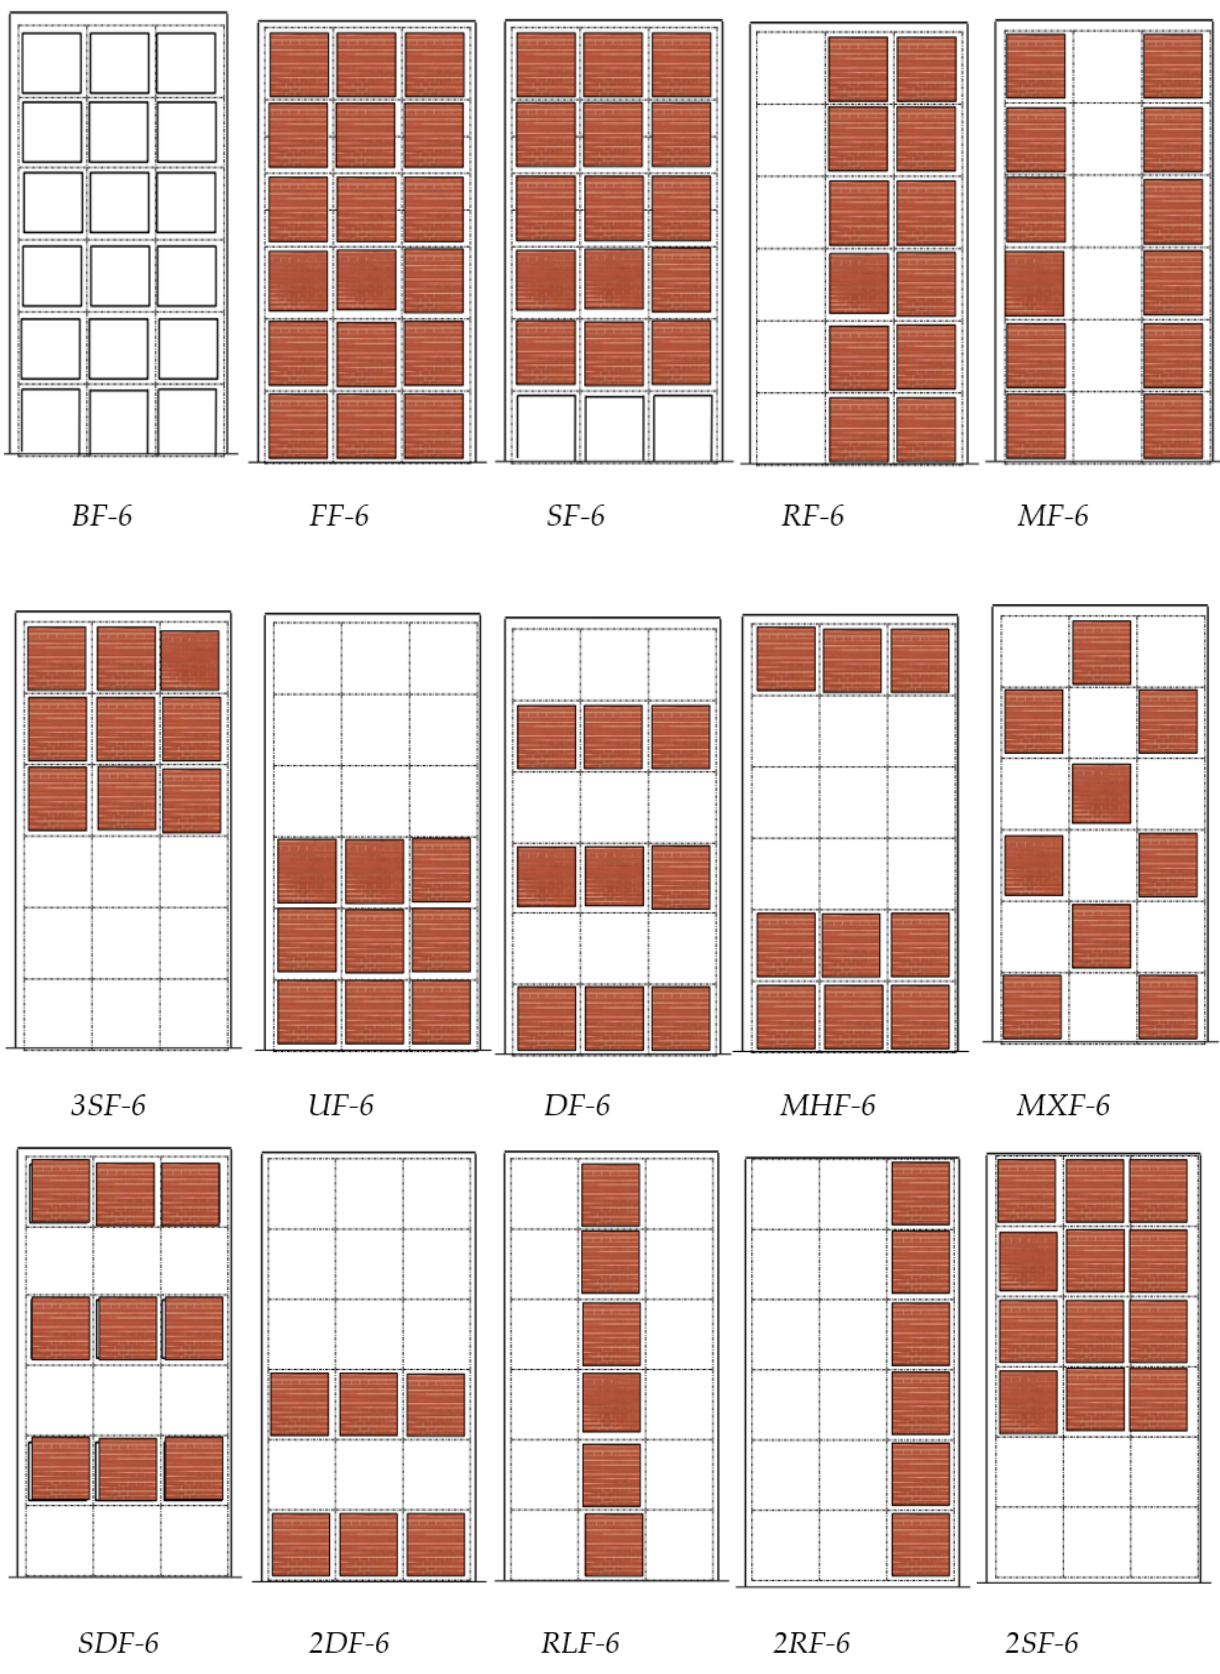
Figure 5. The models with the distribution of the different infill walls.